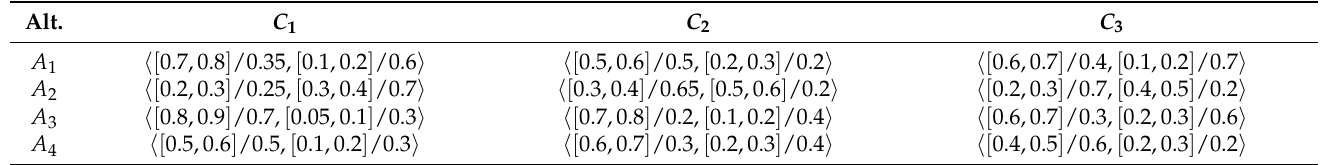
Table 4. Decision matrix R 1 provided by expert e 1 .